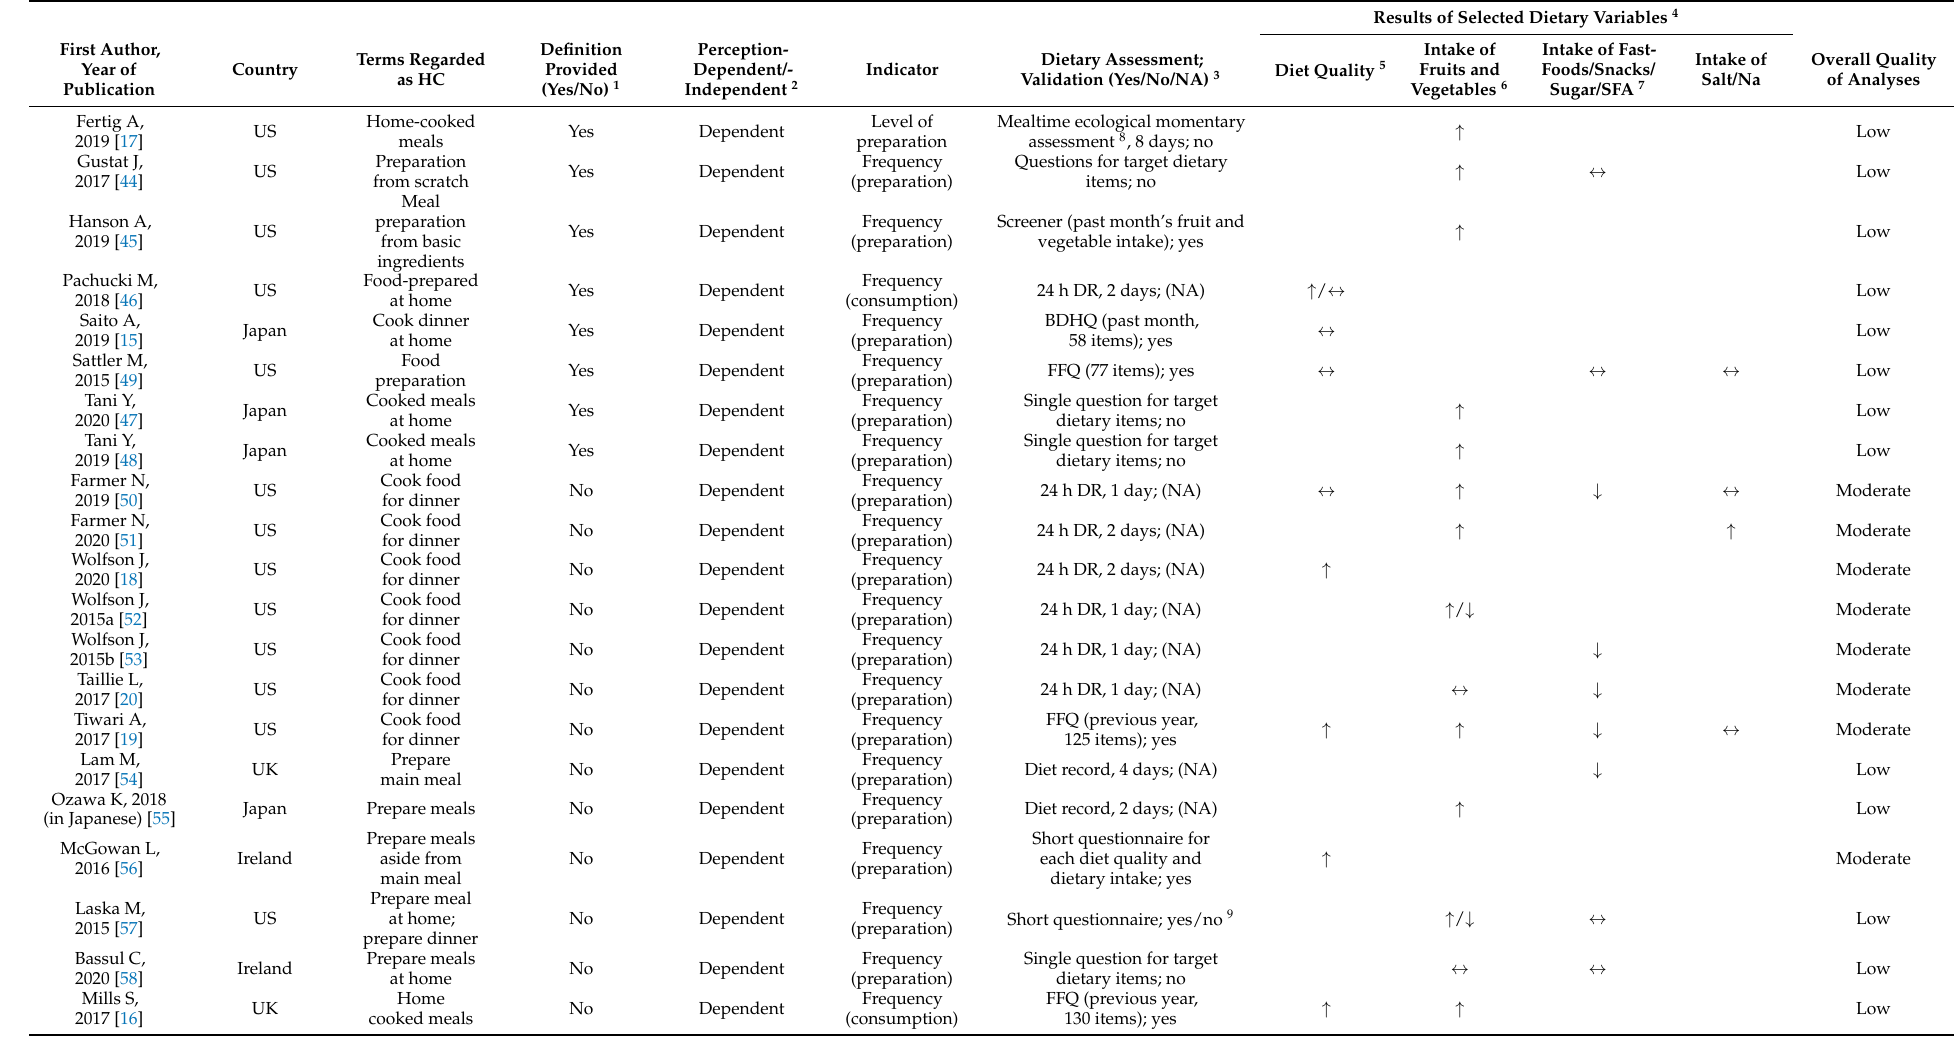
Table 1. Characteristics and selected results of the included studies ( n =